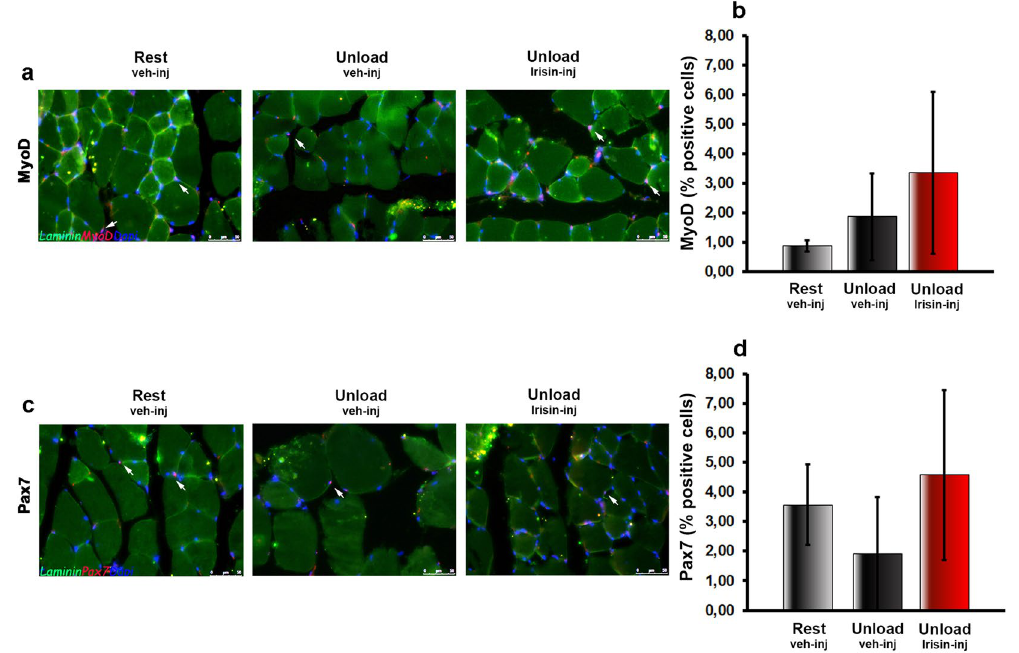
Figure 5. Treatment with r-Irisin does not affect satellite cells in hindlimb-suspended mice. Fluorescent micrographs of vastus lateralis sections from Rest vehicle-injected and Unload vehicle- or Irisin-injected mice, immunostained (red) for MyoD ( a ) and Pax7 ( c ) and counterstained for Laminin (green) and DAPI (blue). The percentage of MyoD positive ( b ) and Pax7 positive ( d ) cells are quantified. Data are presented as mean ± SEM. n = 3 mice per group. All data were normally distributed according to the Shapiro-Wilk normality test and analyzed by one-way ANOVA and Bonferroni’s post hoc